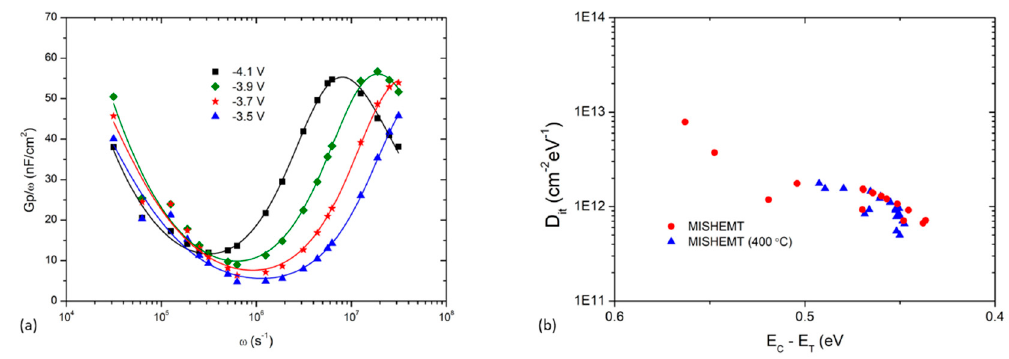
Figure 4. ( a ) G p / ω versus radial frequency plot for different gate voltages of post-gate annealed LTE-AlN MIS-diode at 400 °C (solid lines are fitting curves). ( b ) Distribution of interface state density as a function of the gate voltage of as-deposited LTE-AlN MIS-diodes [22] and post-gate annealed MIS-diodes at 400 °C.